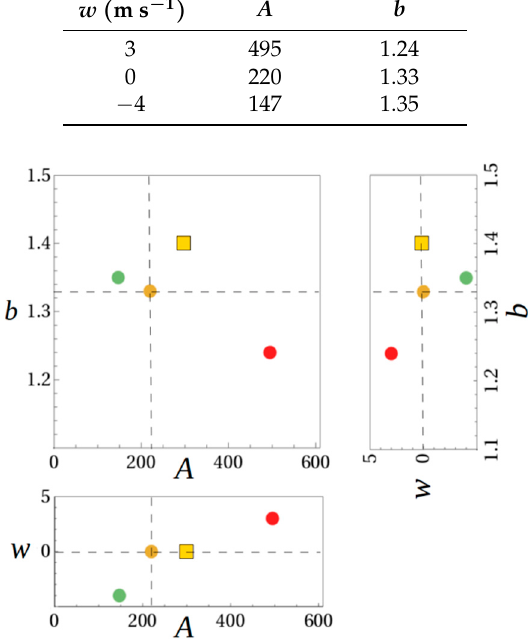
Figure 10. Data from Table 1, with NWS A - b coefficients (yellow square) for comparison. Table 2. Linear fit to simulation of Figure 9, log Z = log A + b log R